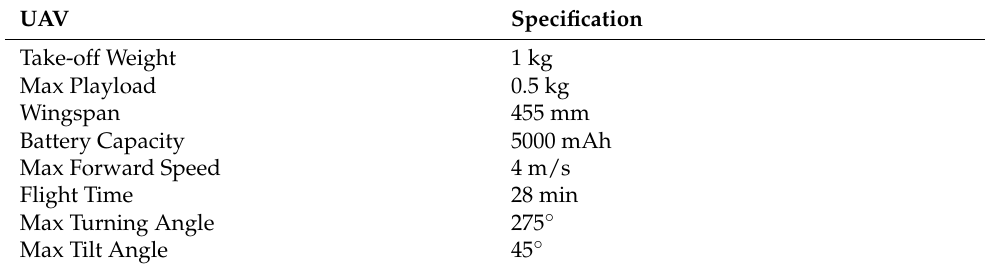
Figure 13. The self-designed four-rotor platform. Table 5. The UAV specifications.